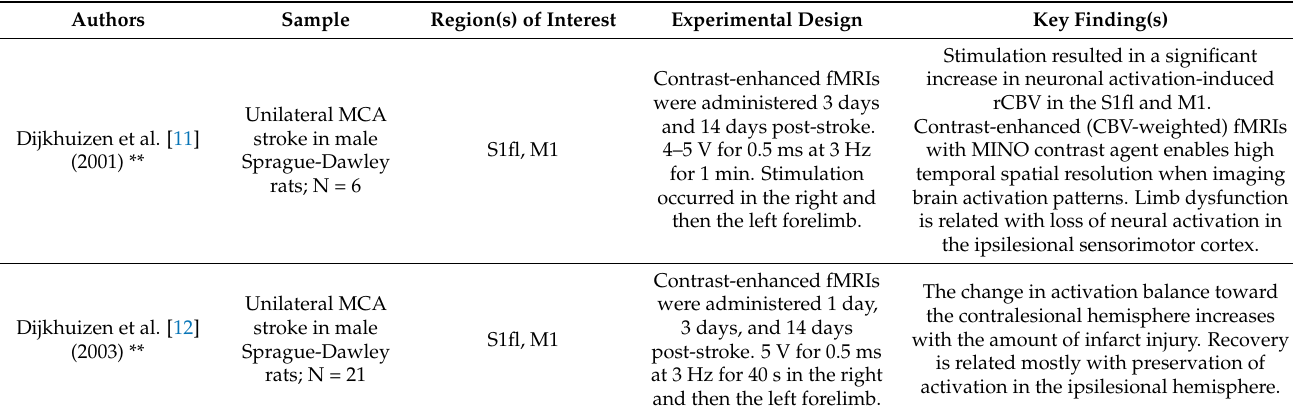
Table 1. Animal studies that incorporated tDCS and